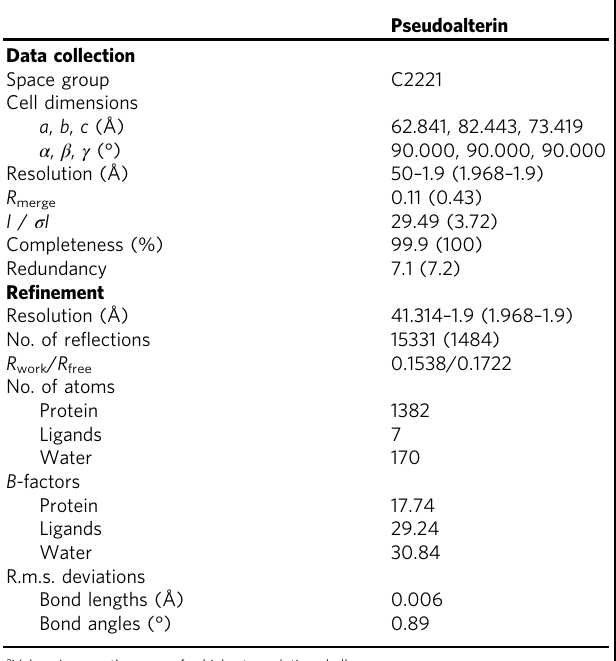
Table 1 Diffraction data and re fi nement statistics of